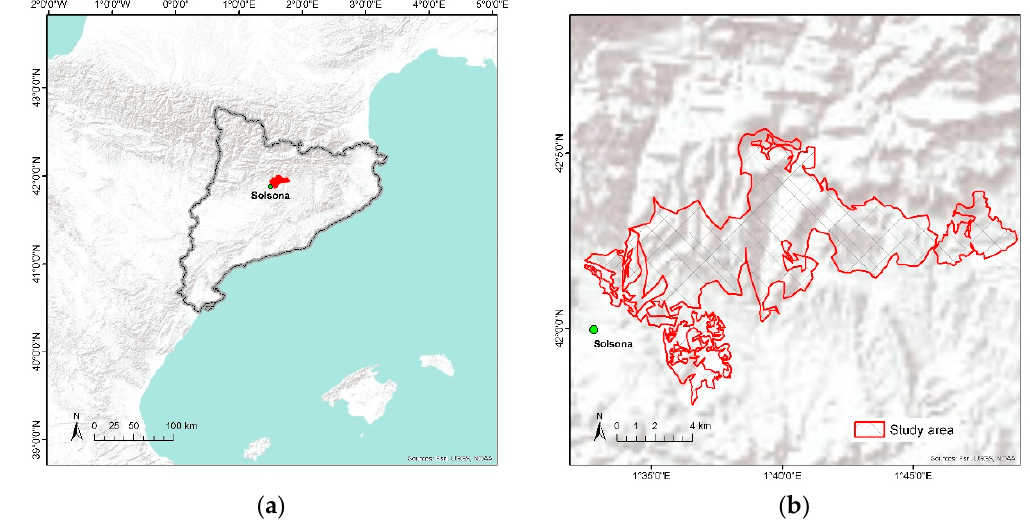
Figure 1. Study area showing: ( a ) Location of Solsona (41°59 ′ 40 ″ N, 1°31 ′ 04 ″ E), Catalonia (solid gray line), Spain; ( b ) one of the most severely affected areas mapped by rural agents (2016).